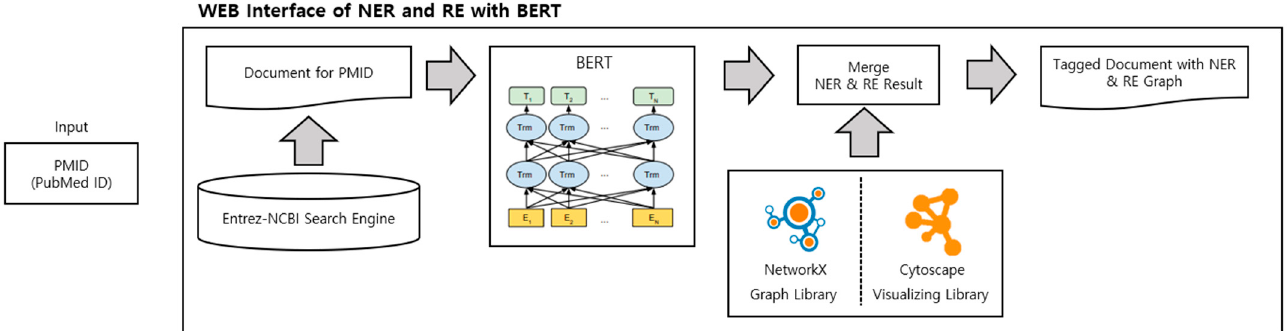
Figure 1. Overview of web interface of NER and RE with BERT.